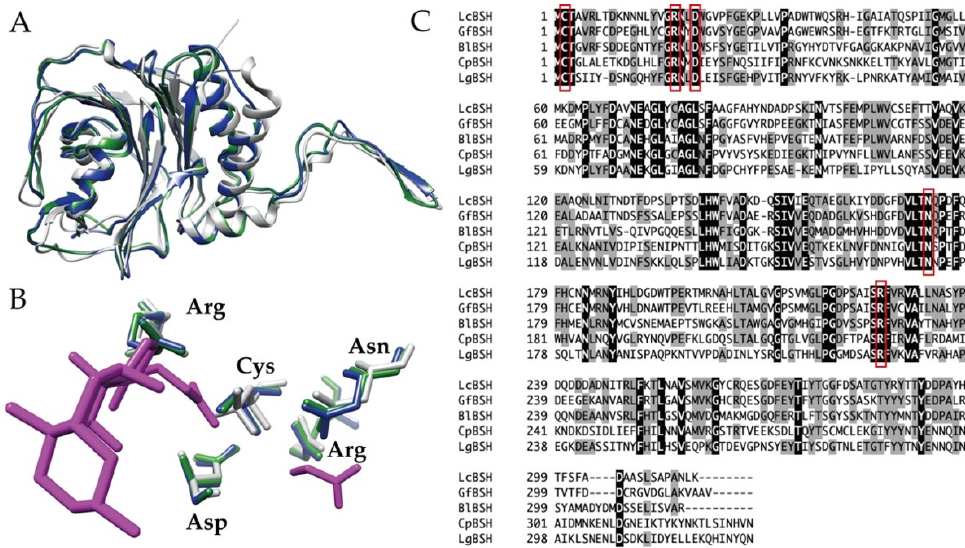
Figure 2. Sequence analyses of the putative LcBSH and GfBSH. ( A ) Overall and ( B ) catalytic active site superposition images of LcBSH (blue) and GfBSH (green) with CpBSH from Clostridium perfringens (gray; PDB accession number 2RLC). The degradation products (glycine and cholic acid) of glycocholic acid by CpBSH are shown in magenta sticks. ( C ) Multiple alignment analysis of the putative LcBSH and GfBSH. Amino acid sequences of LcBSH and GfBSH were compared with characterized bile salt hydrolases (BSHs) from gut bacteria. The black and gray backgrounds indicate identical and similar amino acid residues, respectively. The conserved residues (Cys, Arg, Asp, Asn, and Arg) related to the catalytic active site are boxed in red lines. Abbreviated as: BlBSH (AAF67801) from Bifidobacterium longum SBT2928; CpBSH (P54965) from Clostridium perfringens 13; LgBSH (WP_020806888) from Lactobacillus gasseri FR4.